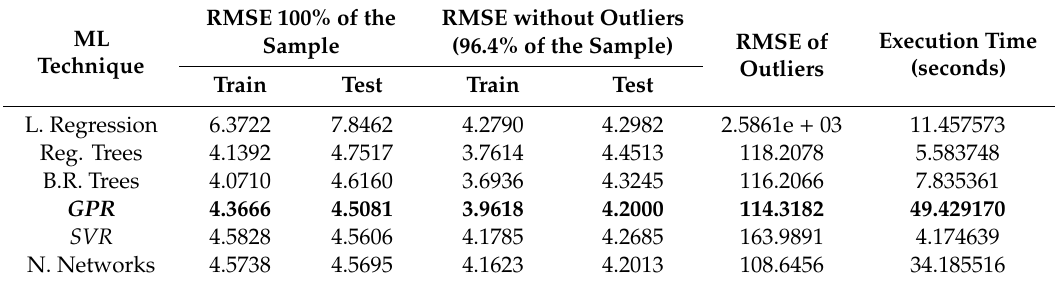
Table 13. BMI-CTDI VOL results for women’s Abdomen protocol.